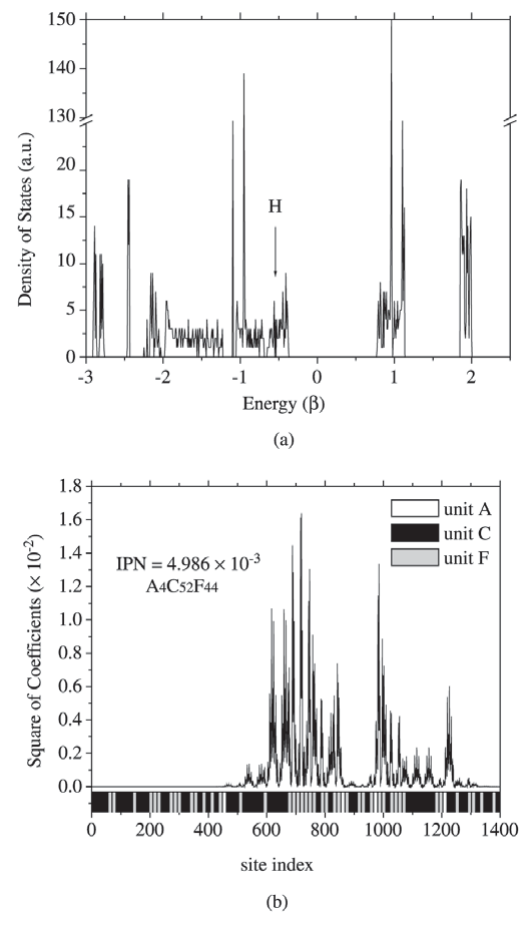
Figure 3. a) Density of electronic states for the proposed GA solu- tion. The arrow indicates the position of the Fermi level; b) Square of corresponding HOMO’s expansion coefficients. In the lower part of Fig 3b is indicated the actual chain composition in terms of A, C and F